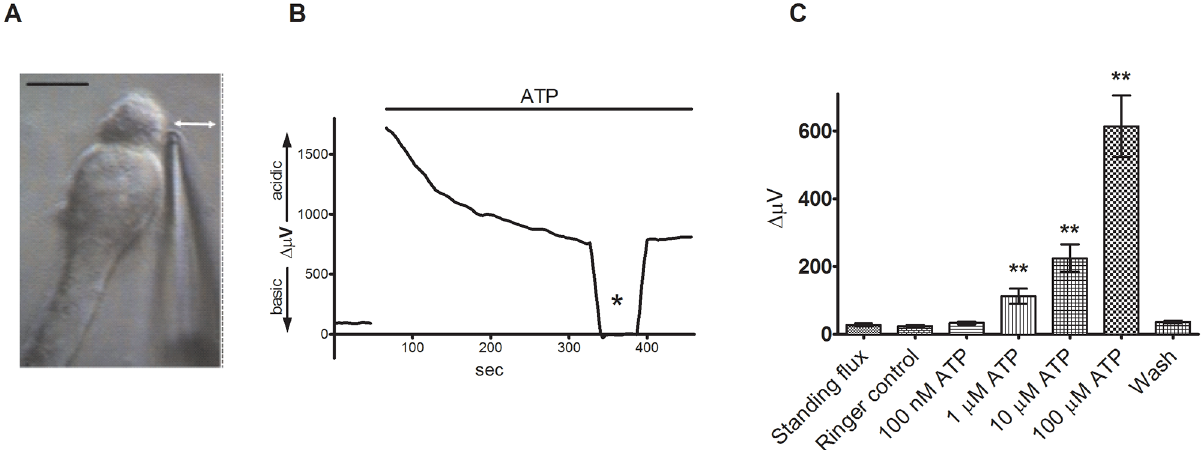
Fig 1. Extracellular ATP induces a significant increase in extracellular H+ flux from isolated Mu¨ller cells. (A) An isolated Mu¨ller cell with a H +-selective microelectrode positioned next to the apical end of the cell. Scale bar: 20 μ m; double-headed arrow depicts the direction of electrode movement as it alternately records the potential established by protons adjacent to the cell and 30 μ m away. (B) Response from a single isolated Mu¨ller cell to 100 μ M ATP. Top bar represents duration of drug application. Asterisk: background control readings taken 200 μ m above the cell. (C) Mean data from 8 trials in response to various extracellular ATP concentrations: error bars represent SEMs; data was analyzed with a paired 2-way t-test. Bars represent mean values ± SEM.